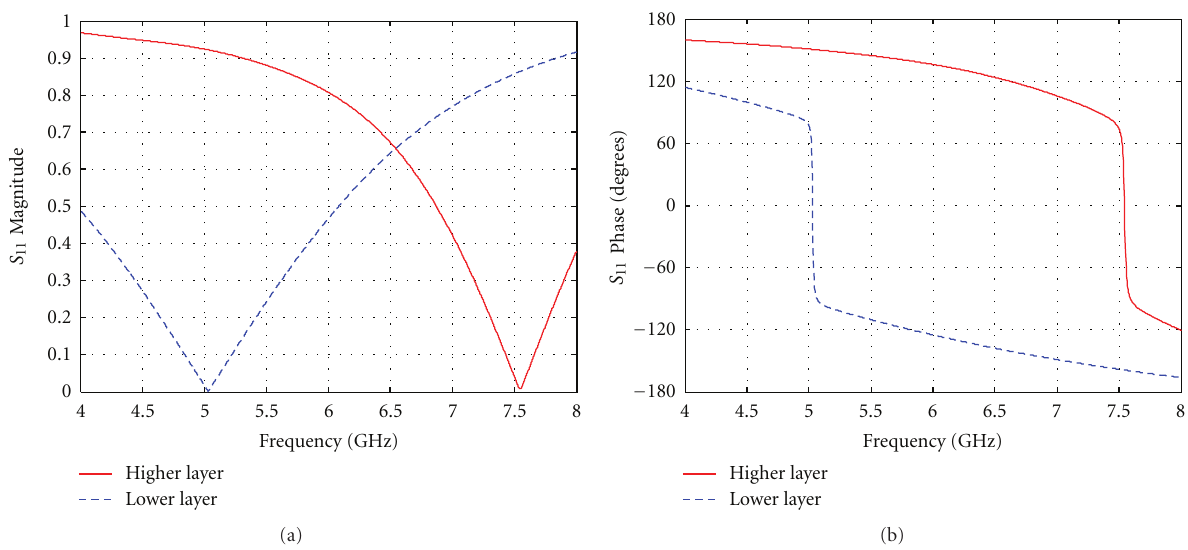
Figure 3: Reflection coe ffi cient (a) magnitude and (b) phase of each FSS